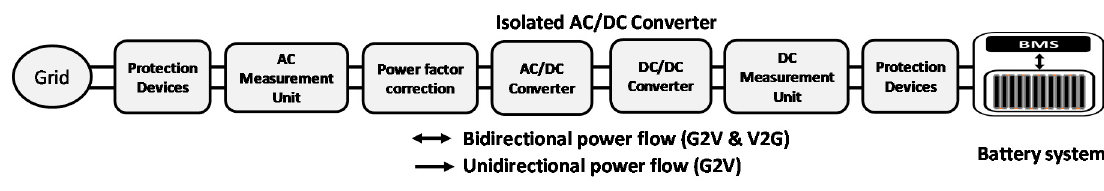
Figure 6. Power flow in a general charger’s structure.